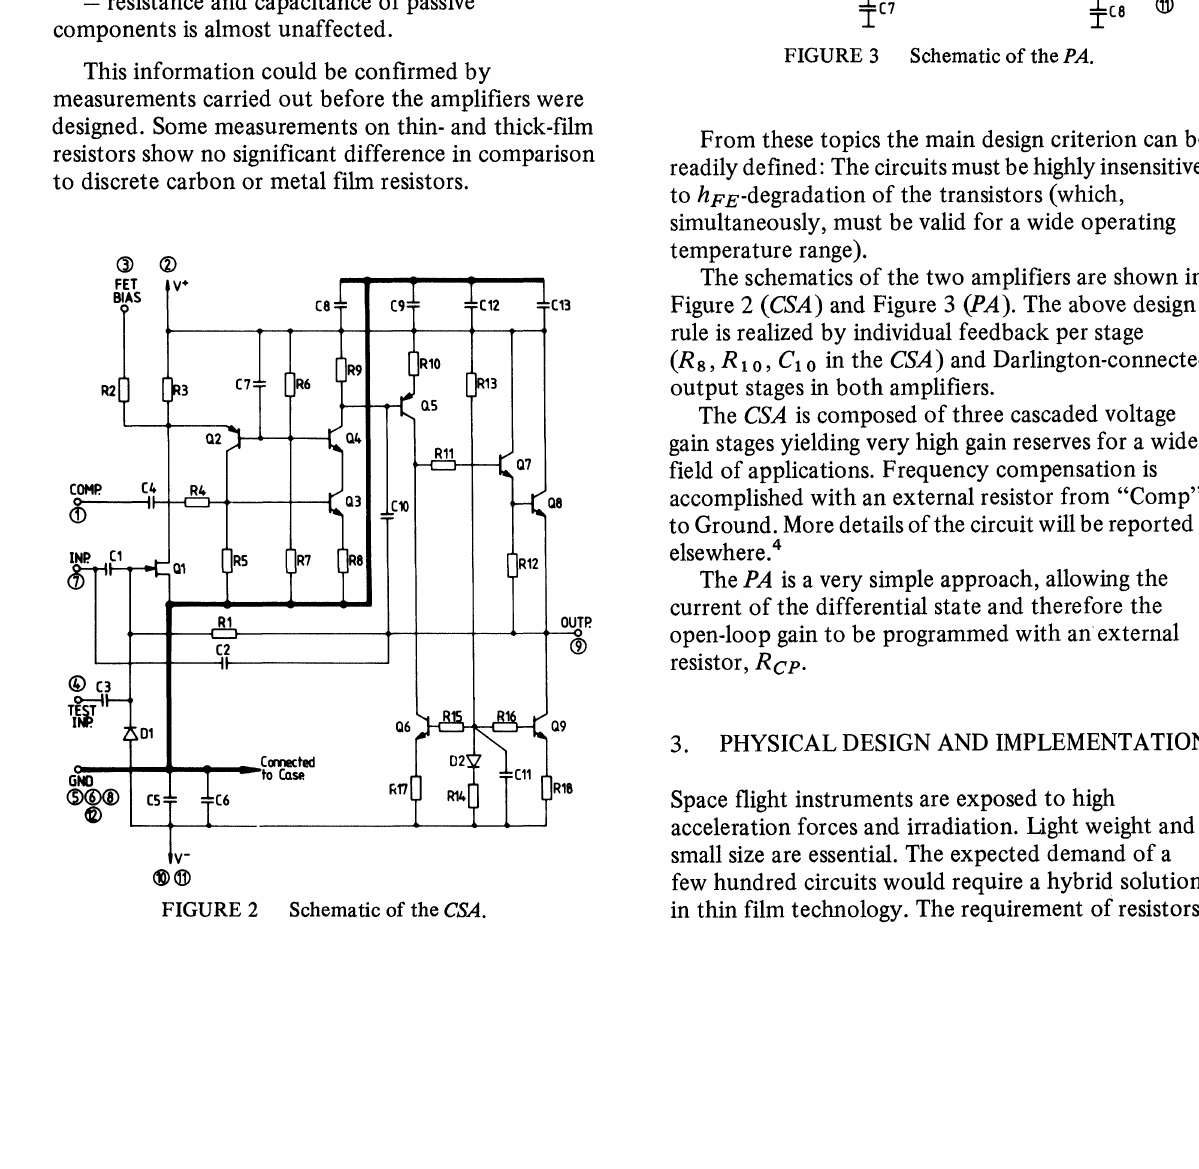
.C7 FIGURE 3 Schematic of the PA.